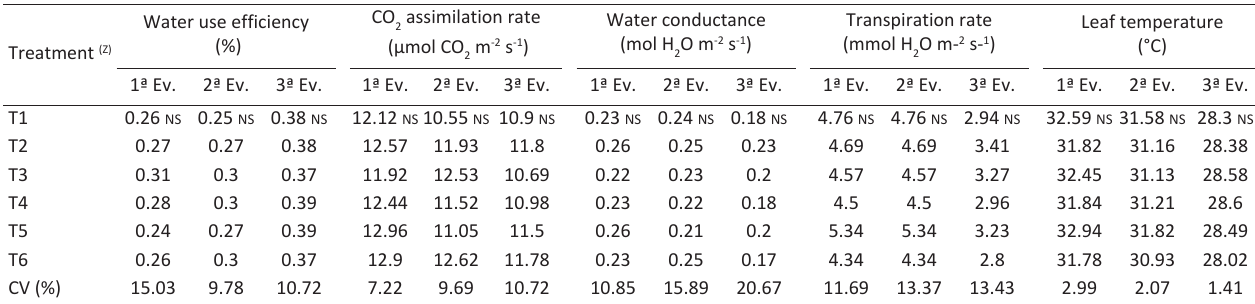
m -2 s -1 ), water conductance (mol H 2